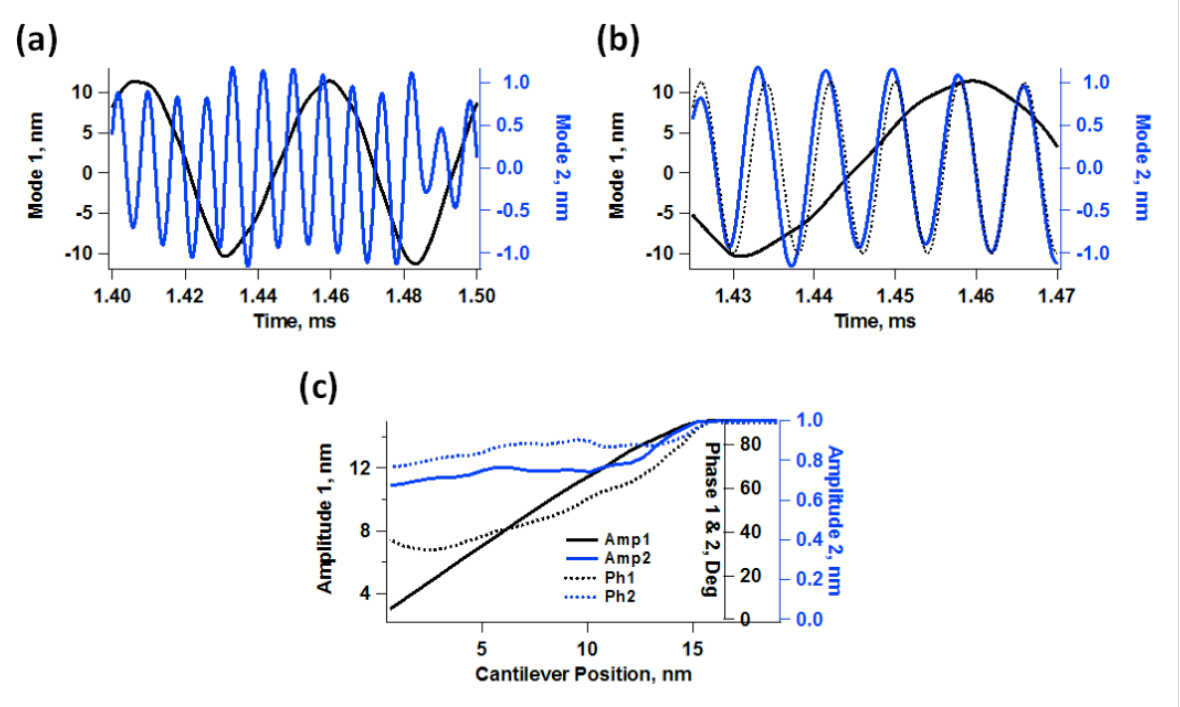
Figure 2: Bimodal AFM simulation illustrating the phase and amplitude relaxation of the second eigenmode: (a) different response of the first and second eigenmode over successive tip–sample impacts (successive tip–sample impacts are different because the ν 2 / ν 1 ratio is generally not an integer); (b) phase relaxation of the second eigenmode (the dotted line shows the fully relaxed response – notice how this eigenmode’s response gets ahead with respect to the dotted line and undergoes a change in amplitude after the impact but then recovers before the next tap); (c) seemingly normal amplitude and phase spectroscopy curves. The cantilever parameters are ν 1 = 20 kHz, k 1 = 0.25 N/m, Q 1 = 3, Q 2 = 6, A free = 15 nm, and A setpoint = 70% (a and b only). The sample was modeled as a standard linear solid (see methods section) with K o = 3.5 N/m, K inf = 3.5 N/m and C d = 1 × 10 − 5